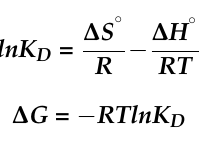
Table 6. Thermodynamics parameters for Congo Red dye adsorption.